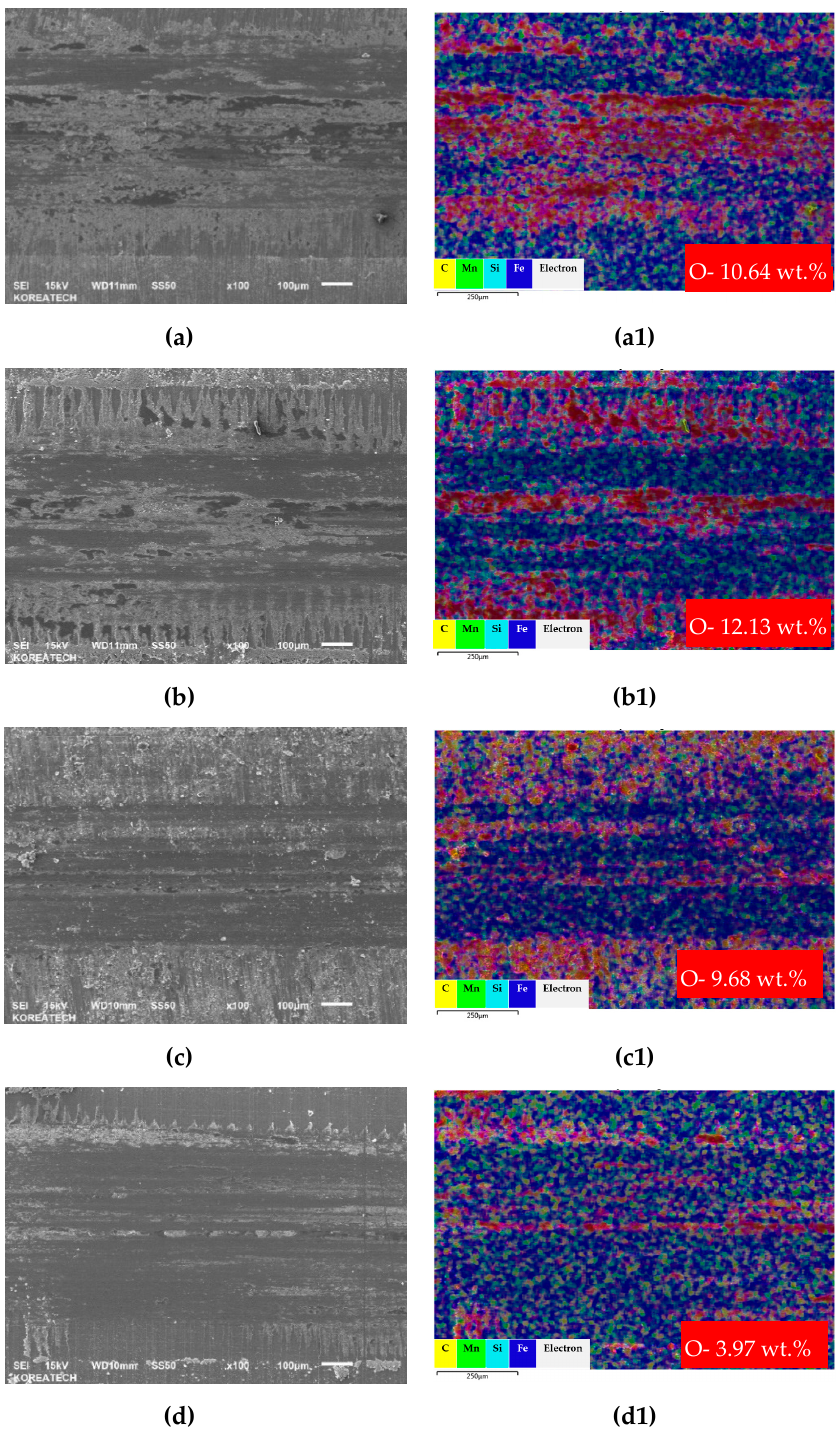
Figure 11. SEM images and mappings of the wear track for the polished ( a , a1 , c , c1 ) and UNSM-treated ( b , b1 , d , d1 ) surfaces for both single and double layers.